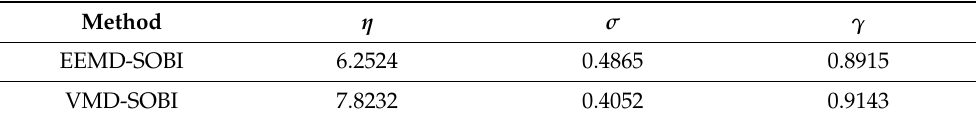
Table 2. Performance indicators under different methods.